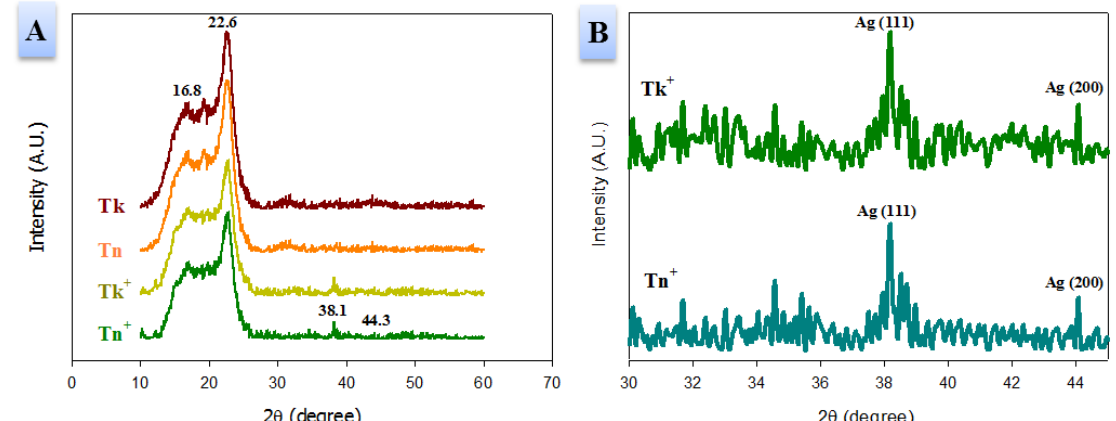
Figure 3. The X-ray diffraction (XRD) analysis of Tk, Tn, Tk + , and Tn + CSNFMs ( A ) and high resolution XRD spectra of Tk + and Tn + CSNFMs ( B ).